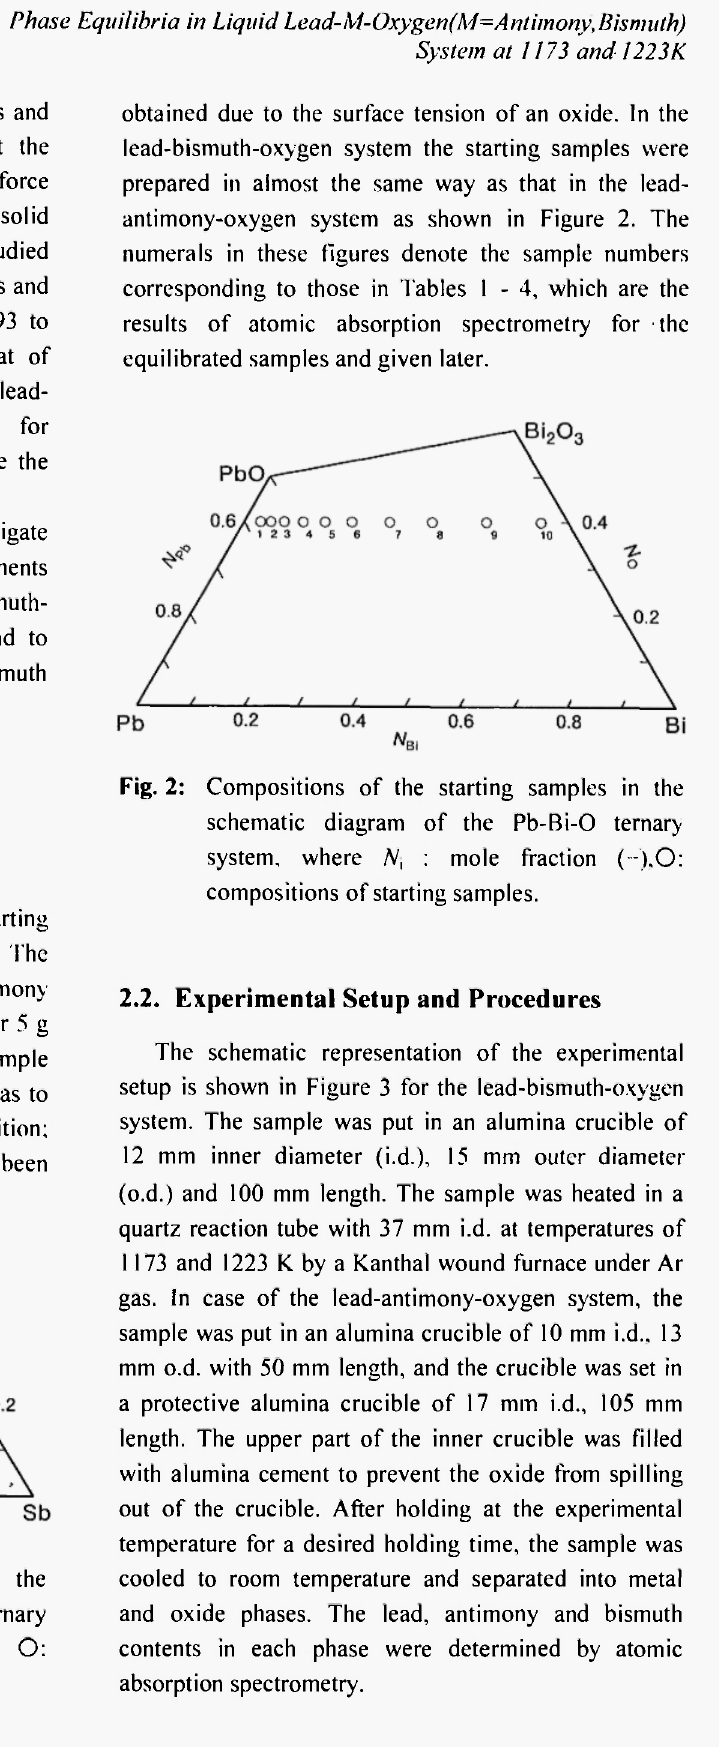
Fig. I: Compositions of the starting samples in the schematic diagram of the Pb-Sb-0 ternary system, where /V, : mole fraction (-), O: compositions of starting samples.